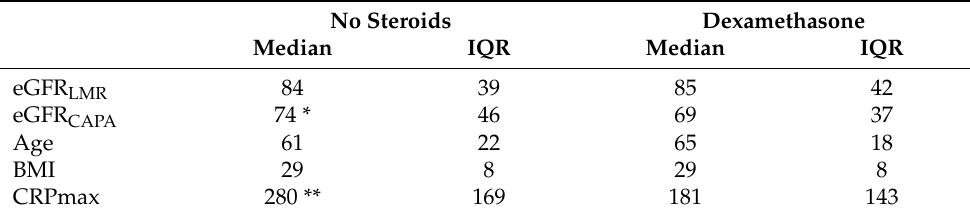
Table 2. Relationships between absolute GFR in mL/min, estimated by the CAPA equation [22] and the 2011 LMR equation [23], age (years), body mass index (BMI; weight (kg) × height (m) − 2 , and CRP maximal value (mg × L − 1 ) during ICU